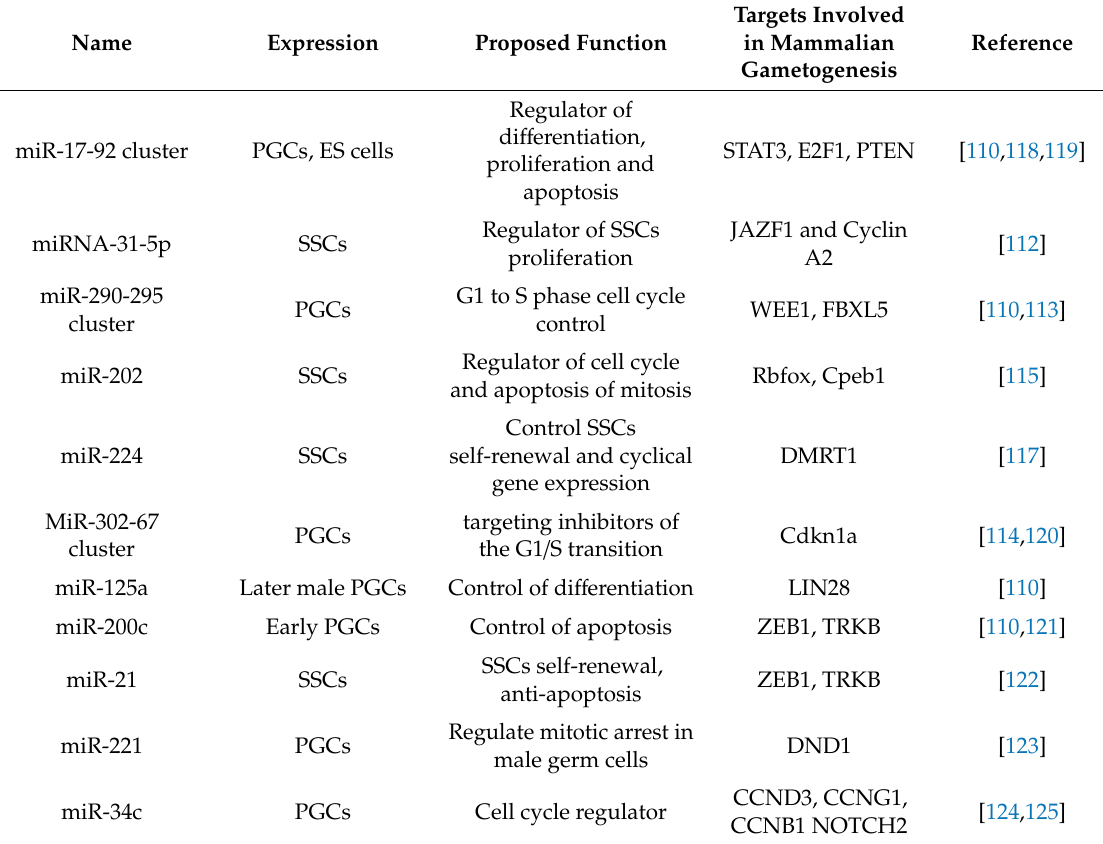
Table 1. miRNA molecules implicated in germ cell